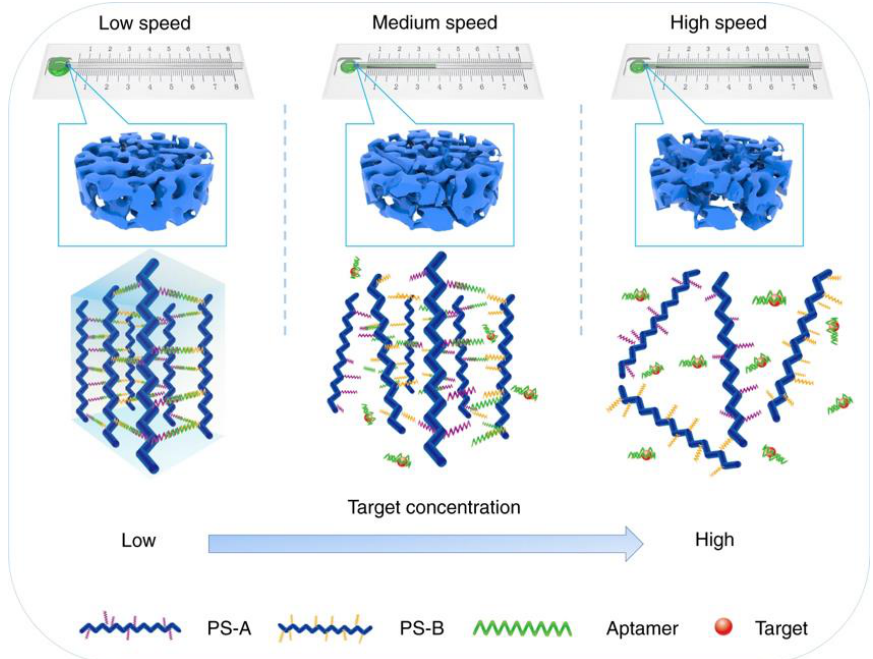
Figure 12. The working principle of the CSDR-Sensor. The addition of target will result in the degradation of hydrogel to a certain degree and then change the permeability of gel in the capillary tube and regulate the capillary action via membrane permeability. (Reprinted from [137]).